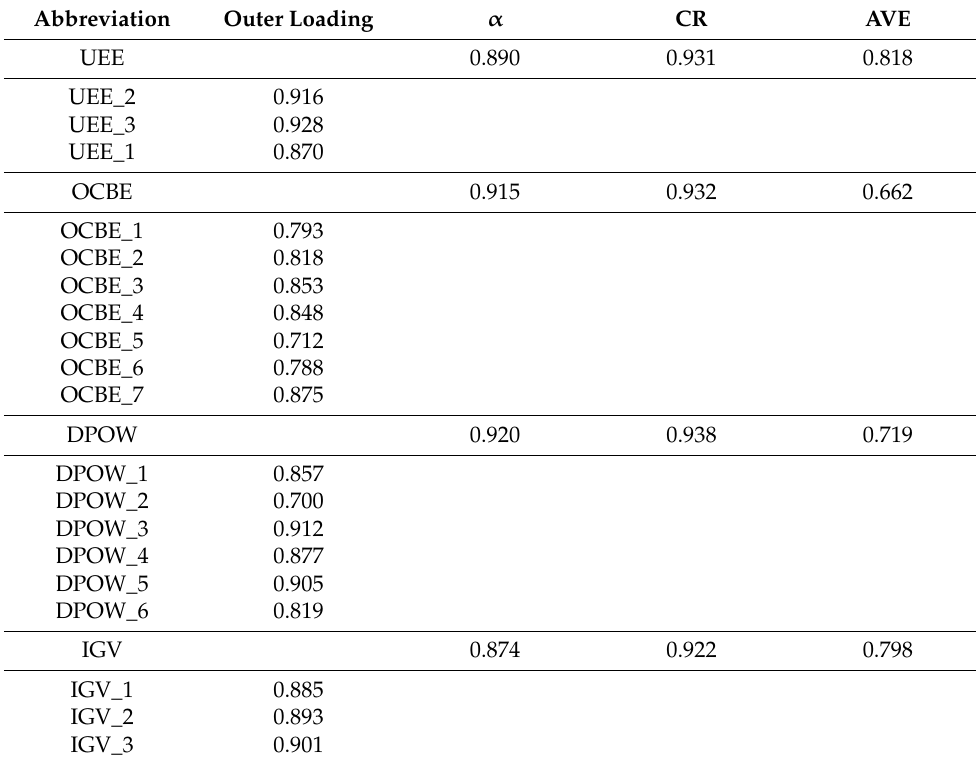
Table 1. Assessment of the formative measurement